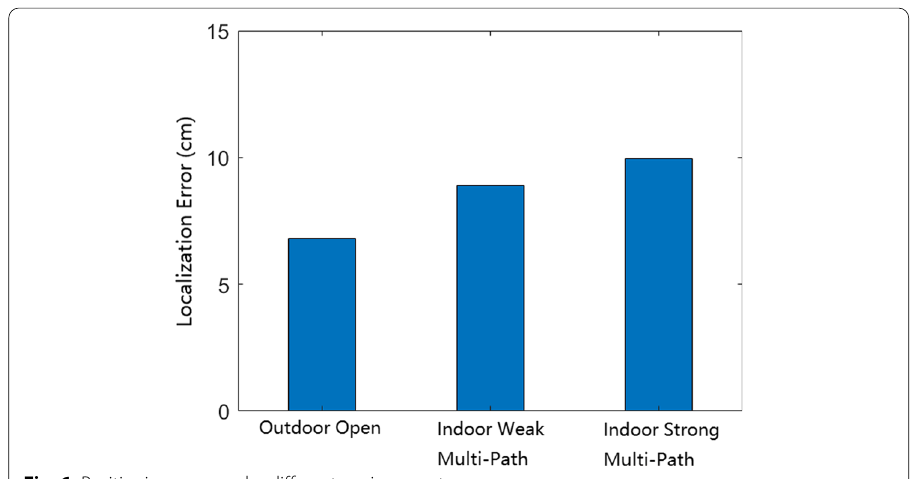
Fig. 6 Positioning error under different